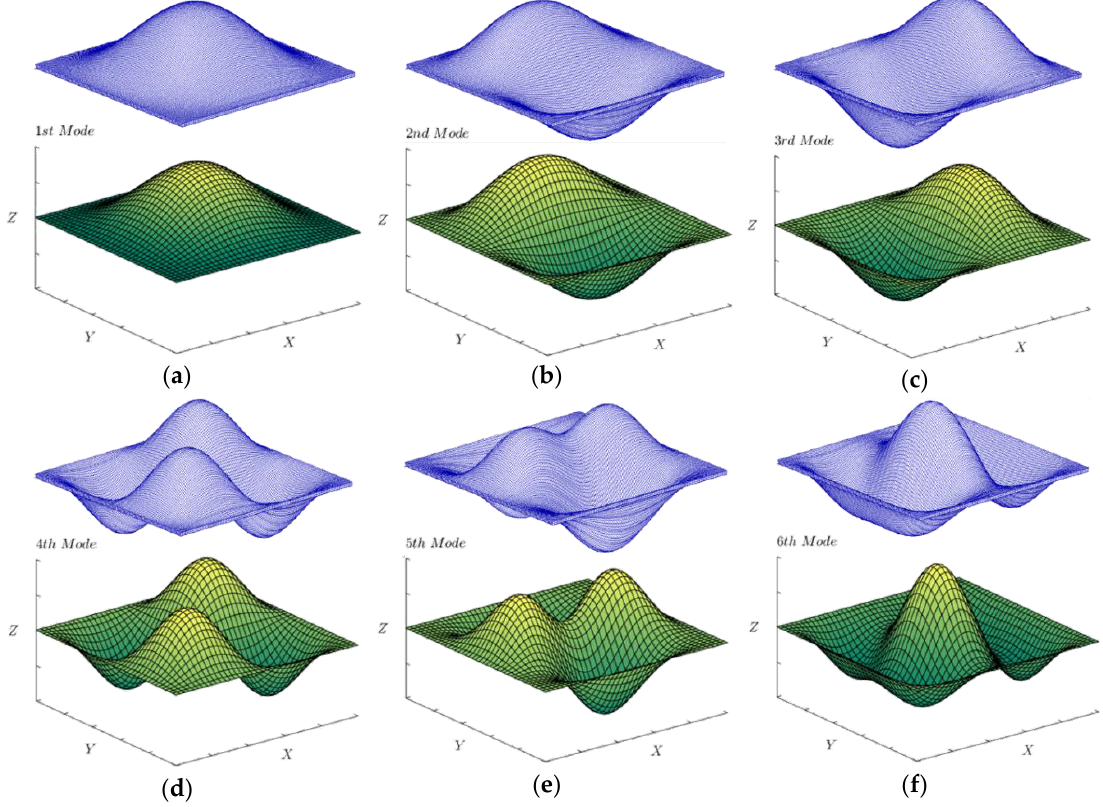
Figure 7. Mode shapes of the ( a ) first; ( b ) second; ( c ) third; ( d ) fourth; ( e ) fifth; ( f ) sixth order of the clamped HCS plate with temperature change Δ T = 100 obtained from MSC.Nastran simulation (blue meshes) and the present method (green meshes).